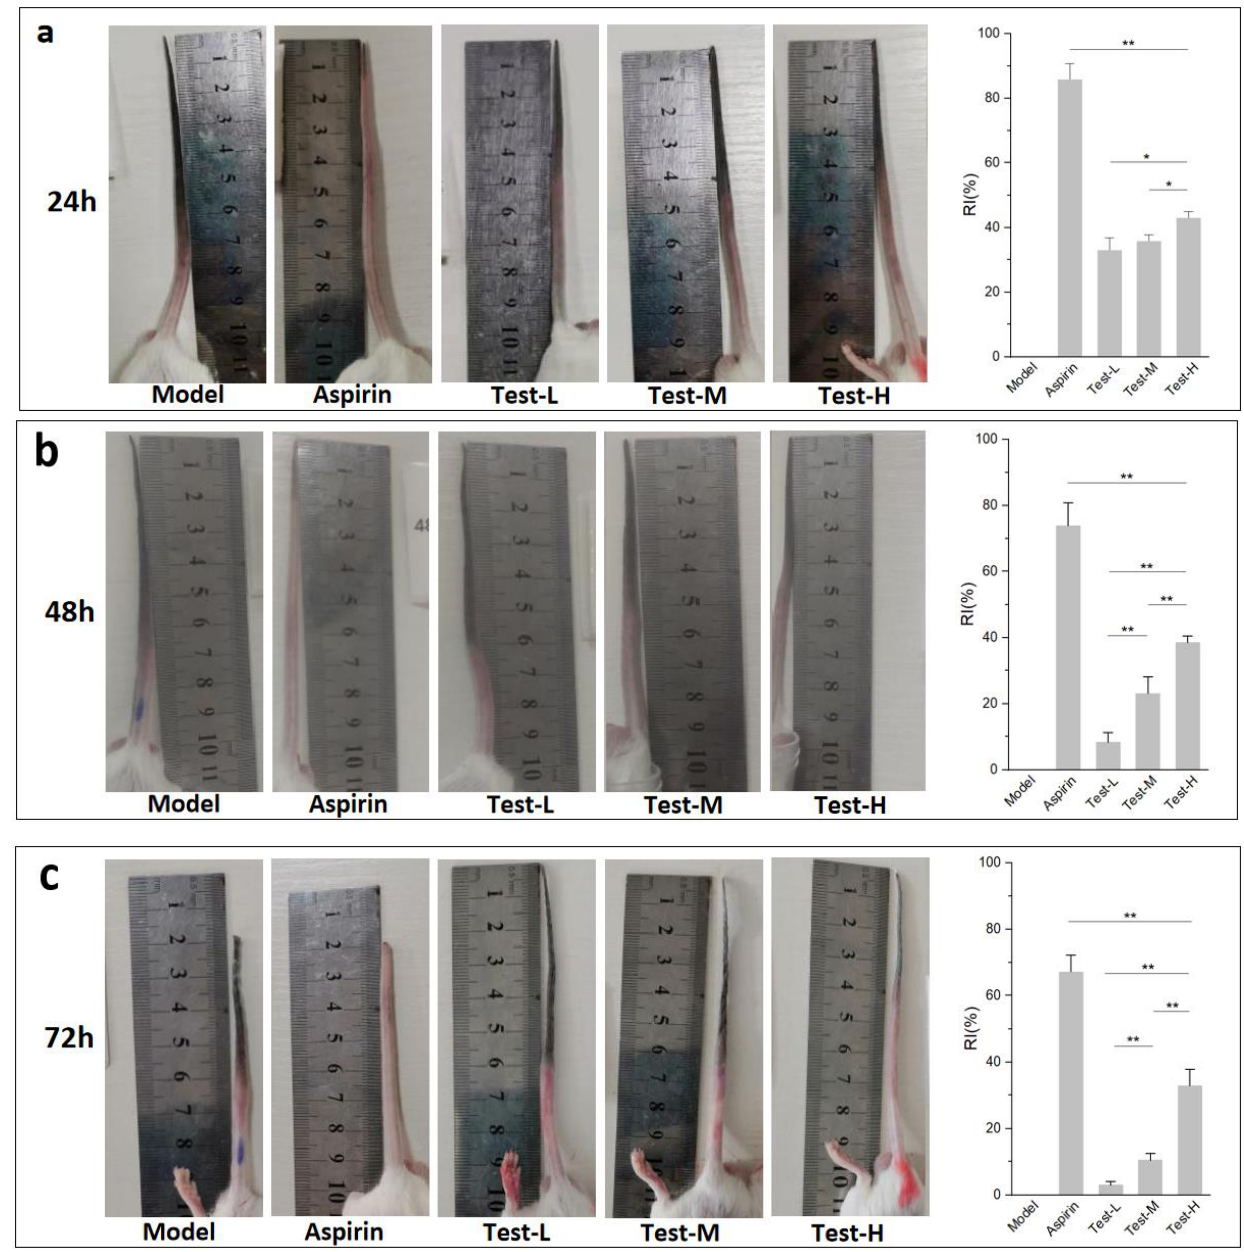
Figure 6. Effects of AAP-b2 on black tail length of mice and the inhibition rate of thrombus relative length (IR) at 24 h ( a ), 48 h ( b ) and 72 h ( c ) after modeling by carrageenan. * p < 0.05 and ** p < 0.01.